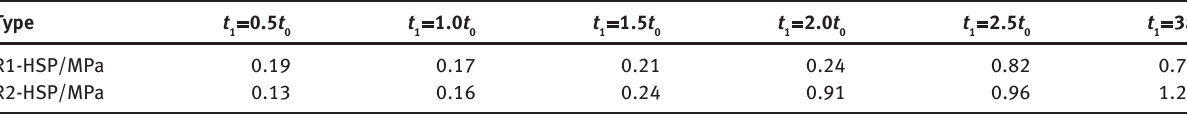
Table 4: Comparison between peak-to-peak stress at plateau stage.